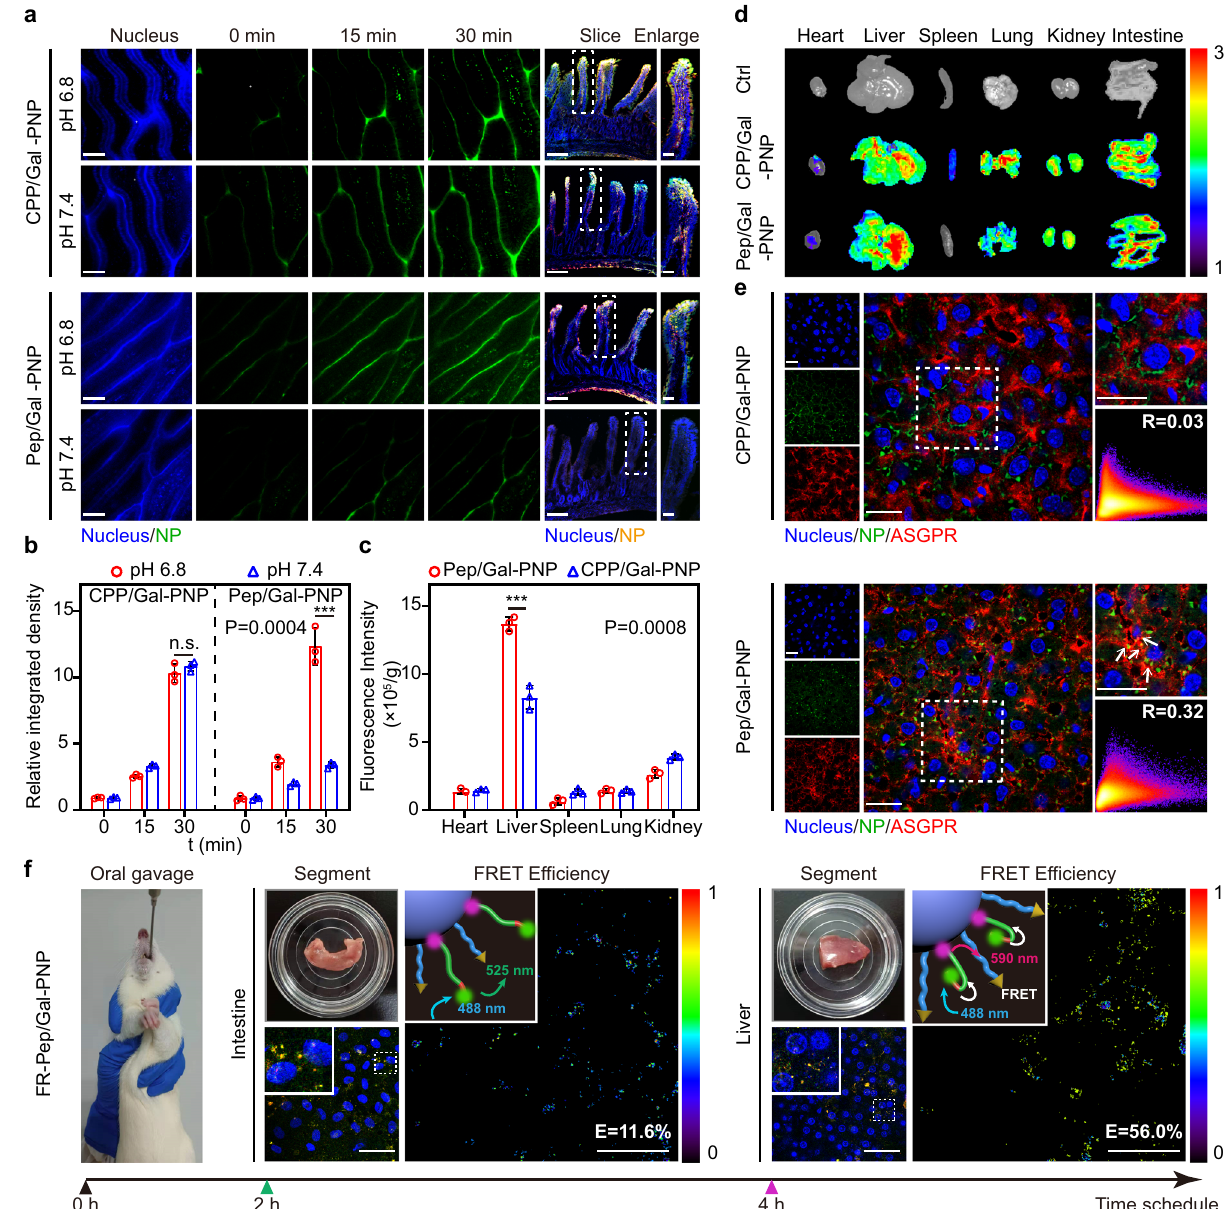
Fig. 5 | In vivo sequential intestinal absorption and liver accumulation of Pep/ Gal-PNPs. a Two-photon microscopy (TPM) images show the absorption of nano- particles in intestinal villi. Scale bar: 100 μ m. Confocal laser scanning microscopy (CLSM) images of intestinal villus sections. Scale bars: intestinal slice images, 200 μ m; enlarged images, 50 μ m. b Quantitative analysis of the absorption of nano- particles in intestinal villi. Data are presented as the mean±SD ( n =3 biologically independent experiments). n.s., not signi fi cant, *** p =0.0004, two-tailed Student ’ s t -test. c The fl uorescence intensity of different tissue homogenates prepared from rats 4h after the oral administration of FITC-labeled nanoparticles. Data are